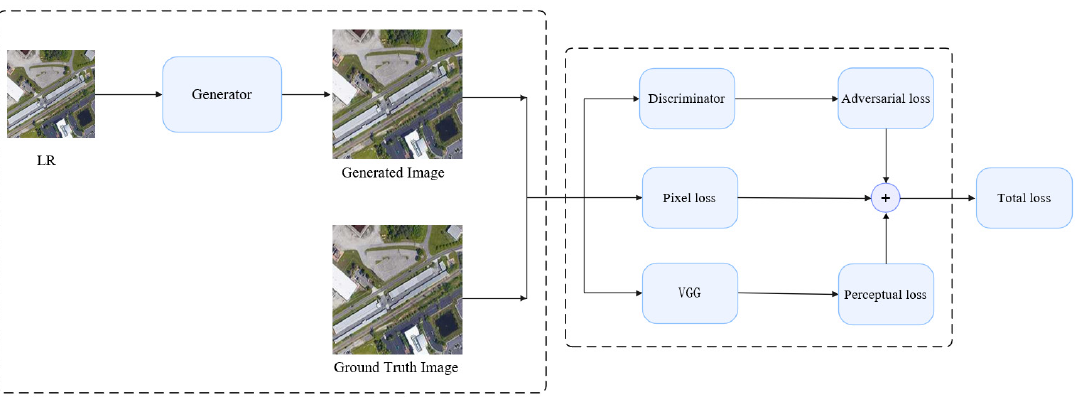
Figure 5. The overall framework of the proposed network.